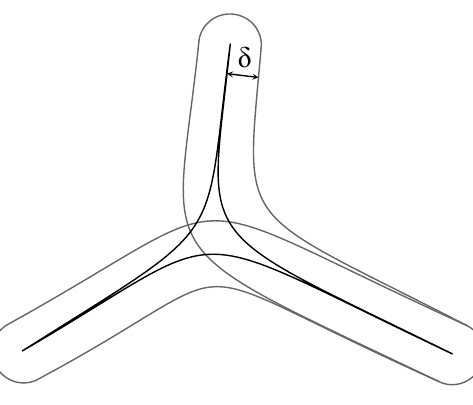
Figure 3: A geodesic triangle in a δ -hyperbolic